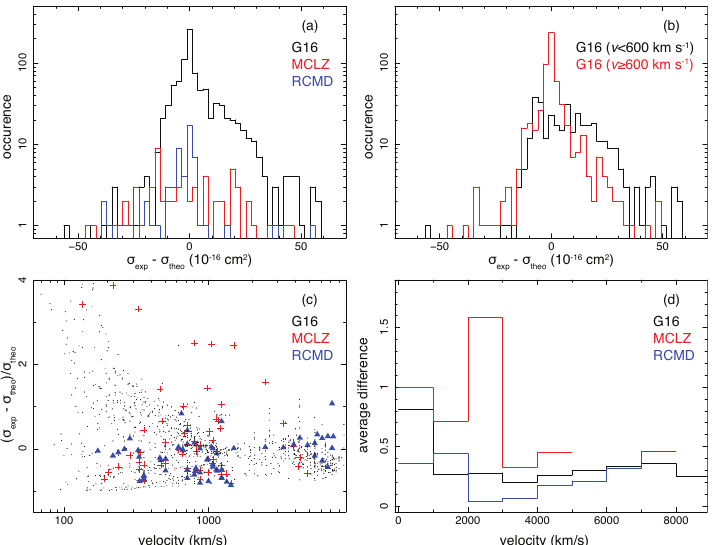
Figure 2. Distributions of the absolute ( upper ) and relative ( lower ) deviations of the theoretical cross sections from the experimental results obtained with the measurements summarized in Table 1. ( a ) Diagrams of the absolute errors for the G16 (black), MCLZ (red), and RCMD (blue) theories. ( b ) Diagrams of the absolute errors for G16 for low-collision velocities (black) and high velocities (red). ( c ) The relative deviations for the G16 (black points), MCLZ (red crosses), and RCMD (blue triangles) calculations. ( d ) The average deviations in absolute values for the three methods in each velocity